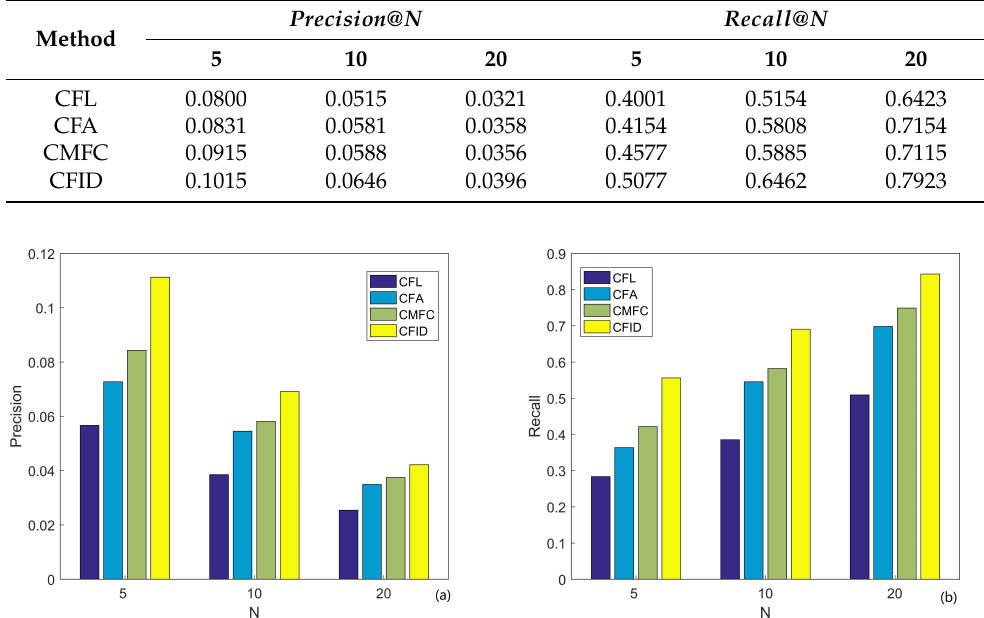
Table 6. Comparative results for multi-person group on Tokyo dataset.